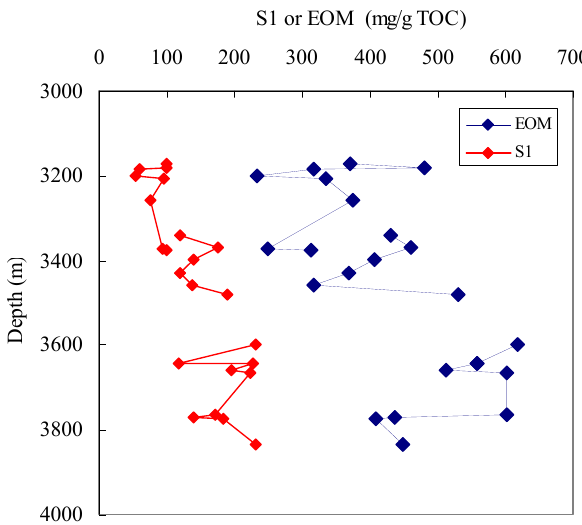
Figure 18. Variations of S1/TOC and EOM/TOC with depth for the studied samples.